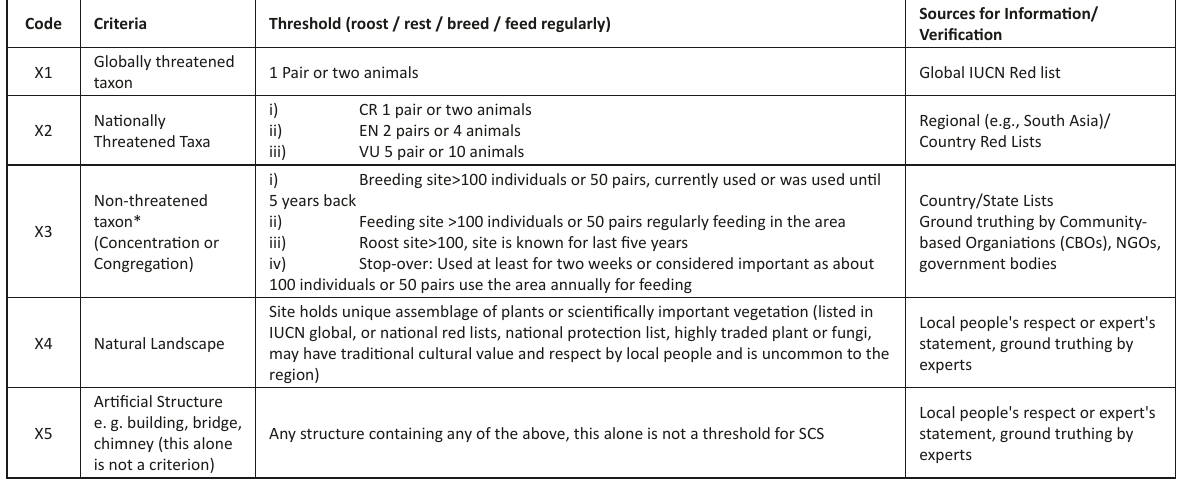
Table 2. Selection criteria for SCS